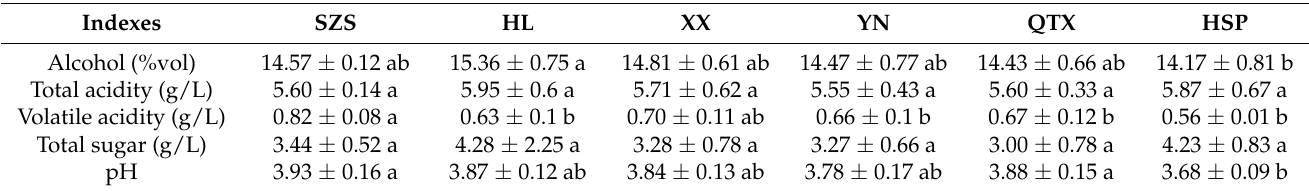
Table 1. Oenological parameters of Cabernet Sauvignon dry red wines from six sub-regions of the Eastern Foothills of Helan Mountain in Ningxia